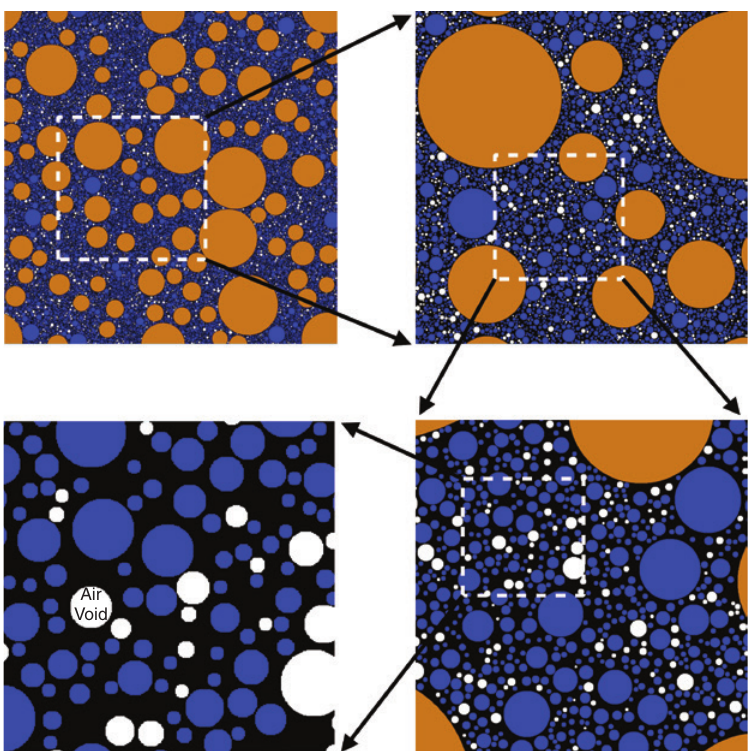
Figure 5: Numerical simulation of hardened concrete with Vinsol resin air-entraining admixtures (white-air voids, blue-fine aggregates, orange-coarse aggregate, and black-cement paste).